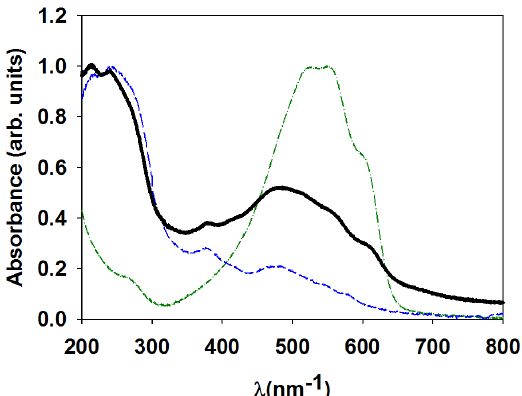
Figure 1. UV–Visible spectra of poly(3-hexyl thiophene) (P3HT, green dot-dashed line), [6,6]-phenyl C71-butyric acid methyl ester (PC 71 BM, blue dashed line) and P3HT:PC 71 BM (black line) thin films, deposited on quartz substrates.